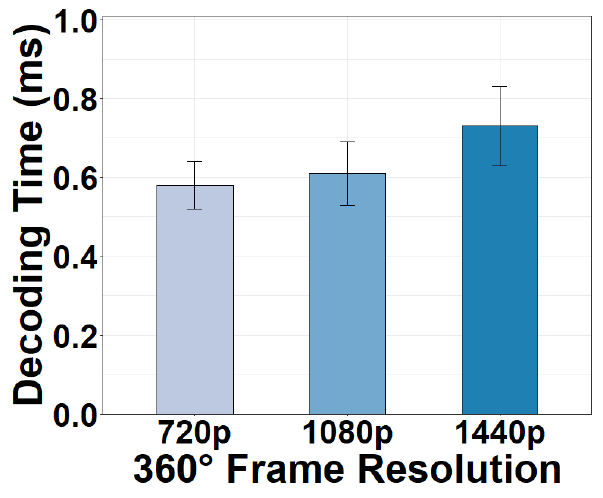
Figure 17. Decoding time versus 360° frame resolutions.